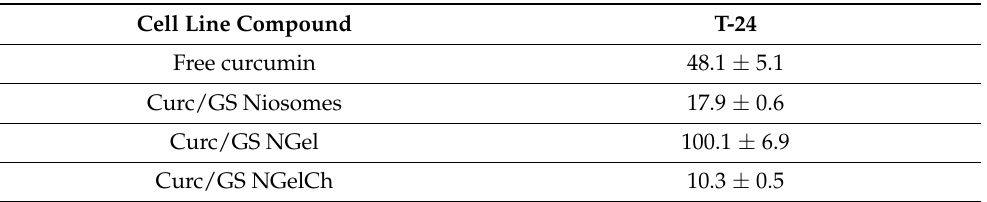
Table 5. In vitro cytotoxicity (IC 50 ( µ M ± SD)) of the free curcumin and its niosomal and thermosen- sitive gel formulations in the screened malignant cell